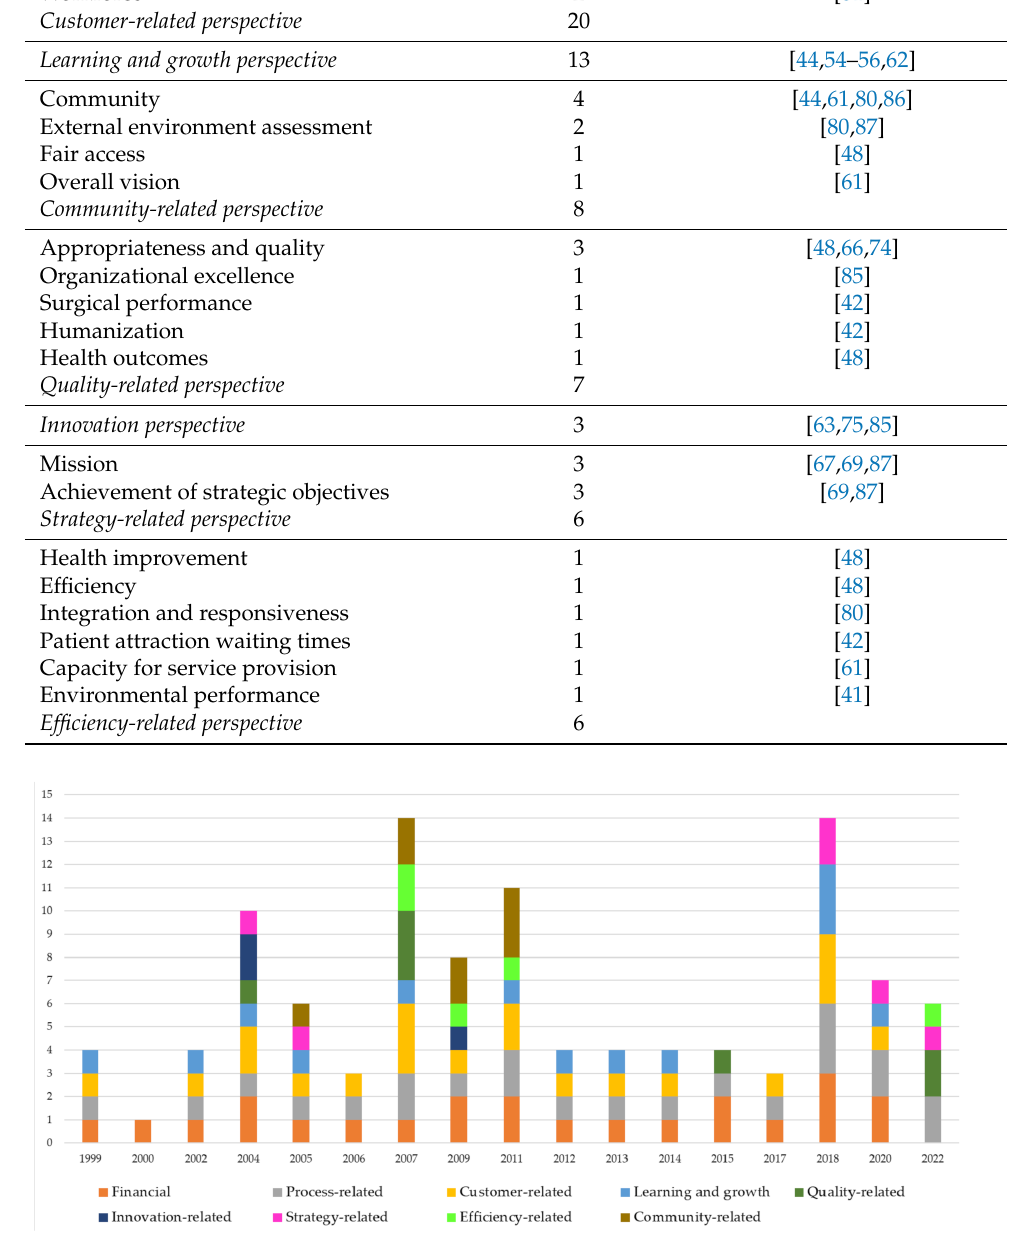
Figure 8. Distribution of papers by BSC perspectives and